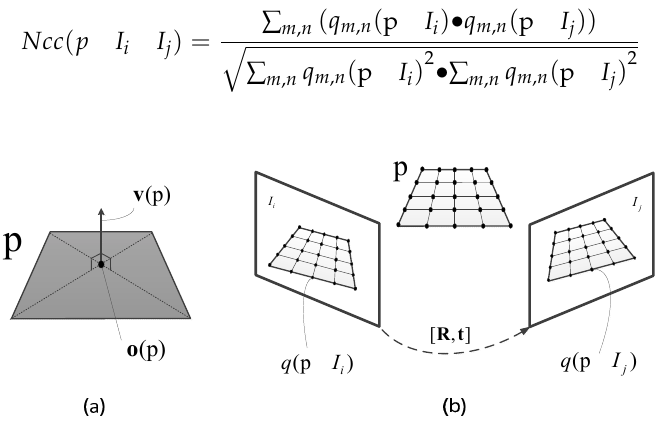
Figure A1. ( a ) A patch is a rectangle with its center and normal denoted as o ( p ) and v ( p ) , respectively. ( b ) The patch p projected into image and establish a correspondence through bilinear interpolation.